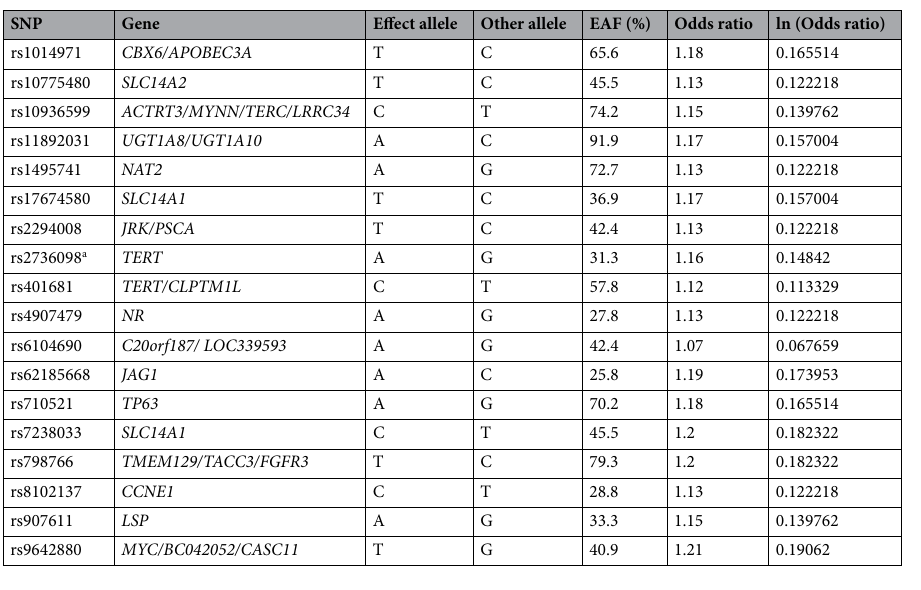
Table 1. List of bladder cancer single nucleotide polymorphisms (SNPs) used to create the weighted genetic risk score. SNP, single nucleotide polymorphism; EAF, effect allele frequency; ln, natural log. SNP information (except rs2736098 [ TERT ]) was obtained externally from genome-wide association studies of BC reviewed in: de Maturana, E. L. et al. Bladder cancer genetic susceptibility. A systematic review. Bladder Cancer . 4 , 215–226. https:// doi. org/ 10. 3233/ blc- 170159 (2018) 7 . a SNP information on rs2736098 ( TERT ) was obtained from